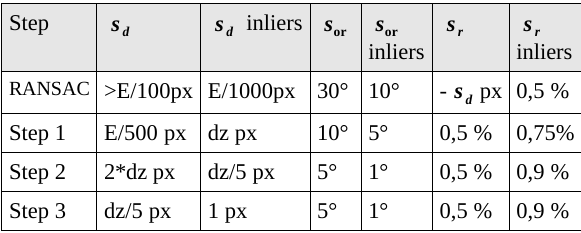
Table 4. Parameters at each step E is the analog scale, dz the subsampling scale. Distance due to rotation error is added to RANSAC s